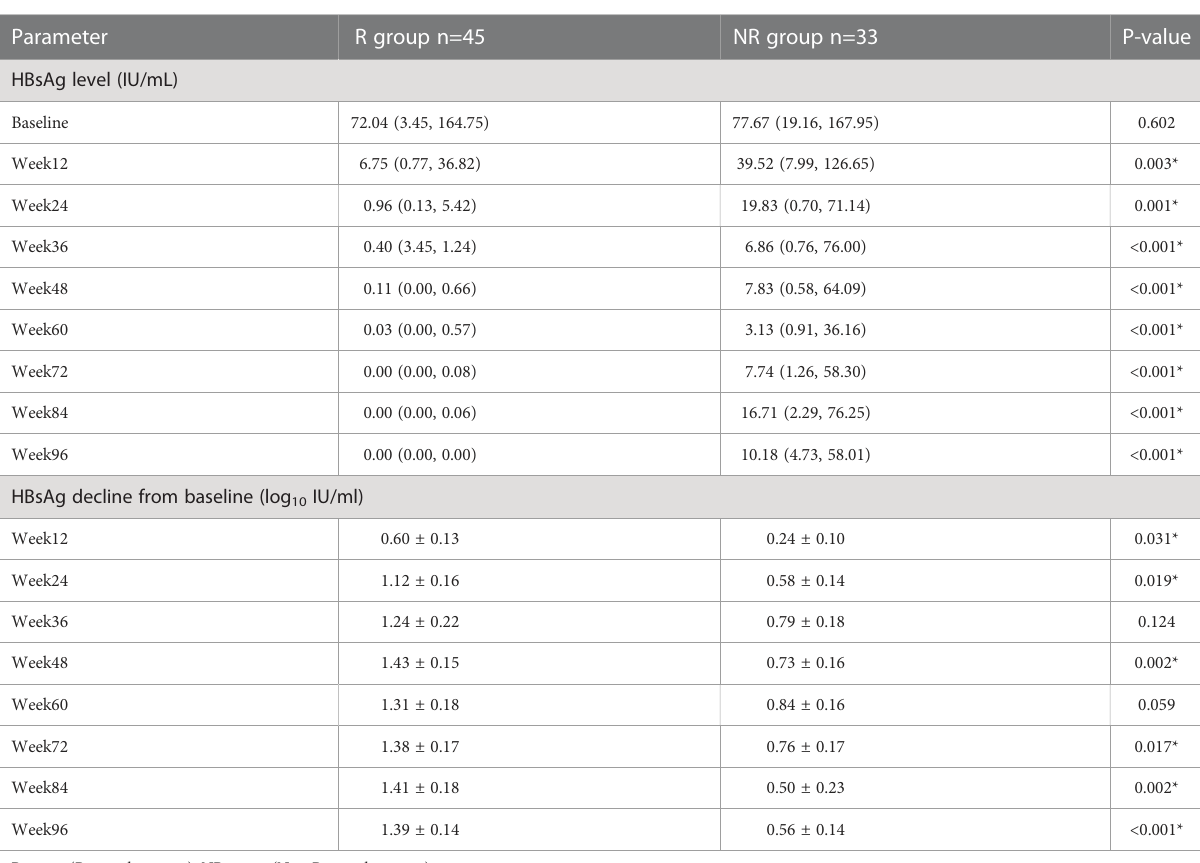
TABLE 2 Longitudinal changes of HBsAg level during treatment.